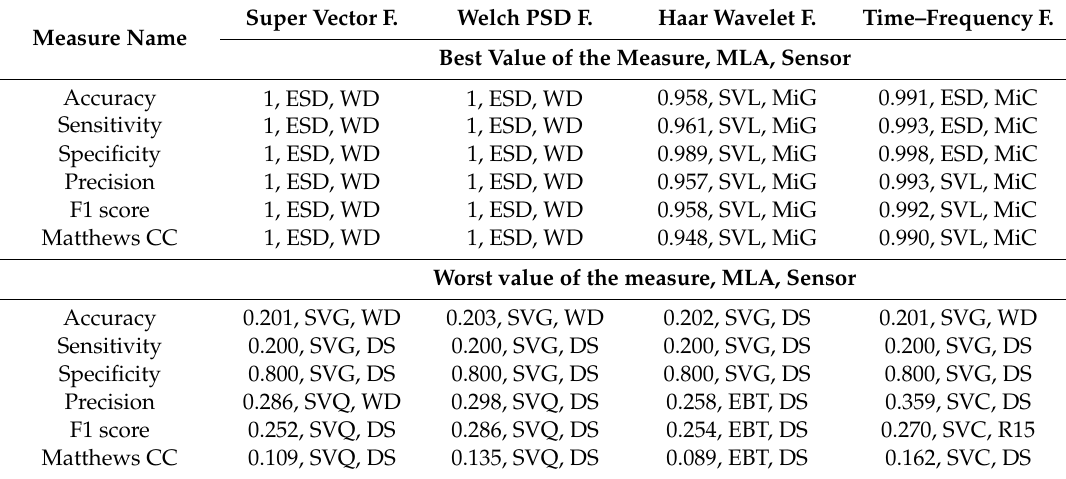
Table 2. Summary of the best and worst values of considered measures, depicting the related MLA and sensor, related to the various feature